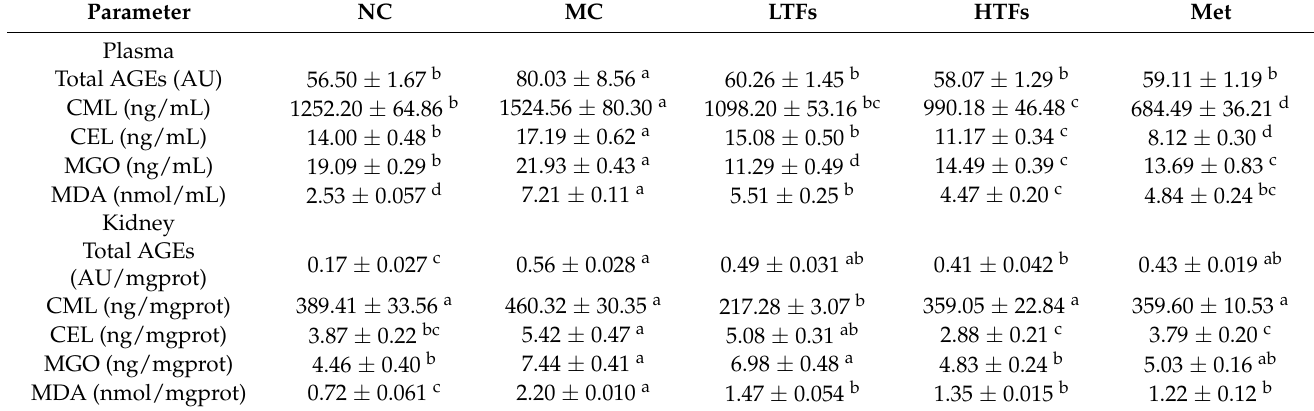
Figure 4. The HE-stain images of kidney tissues of the mice in each group. ( A , B ): kidney tissues images of normal control group mice. ( C , D ): kidney tissues images of diabetic model control group mice. ( E , F ): kidney tissues images of low-dose TFs group mice. ( G , H ): kidney tissues images of high-dose TFs group mice. ( I , J ): kidney tissues images of metformin group mice. Square: glomerular mesangial expansion; rhombus: hyalinization of renal glomerular; triangle: renal tubular epithelial cell exfoliation; arrow: renal tubular epithelial cell vacuolar degeneration; star: glomerular atrophy. Scale bars are 50 µ m and 100 µ m respectively. NC: normal control; MC: diabetic model control; LTFs: low-dose TFs; HTFs: high-dose TFs; Met: metformin. Table 2. Changes in AGEs and their precursor substances in T2DM